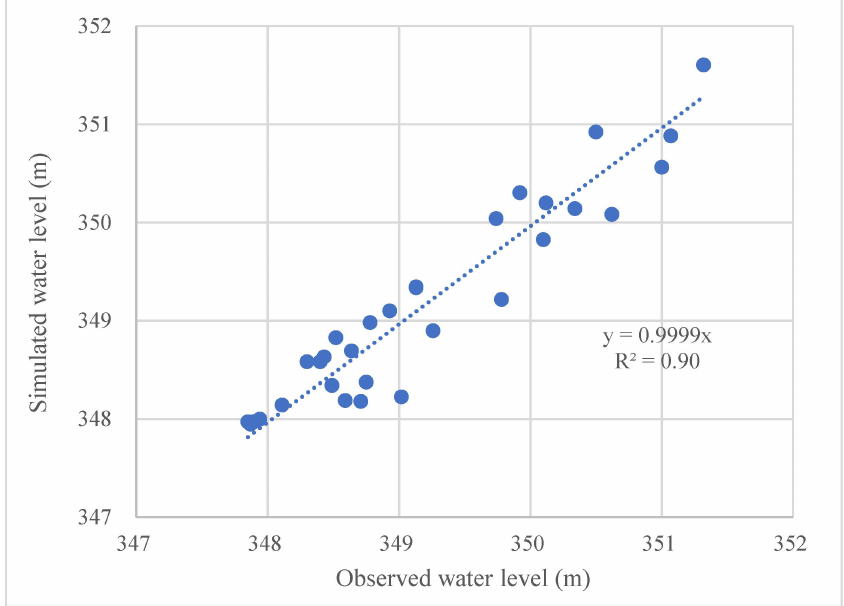
Figure 5. Comparison of the observed and simulated values of COD Mn at: ( a ) LHLZ sampling site; ( b ) DST sampling site; ( c ) GSC sampling